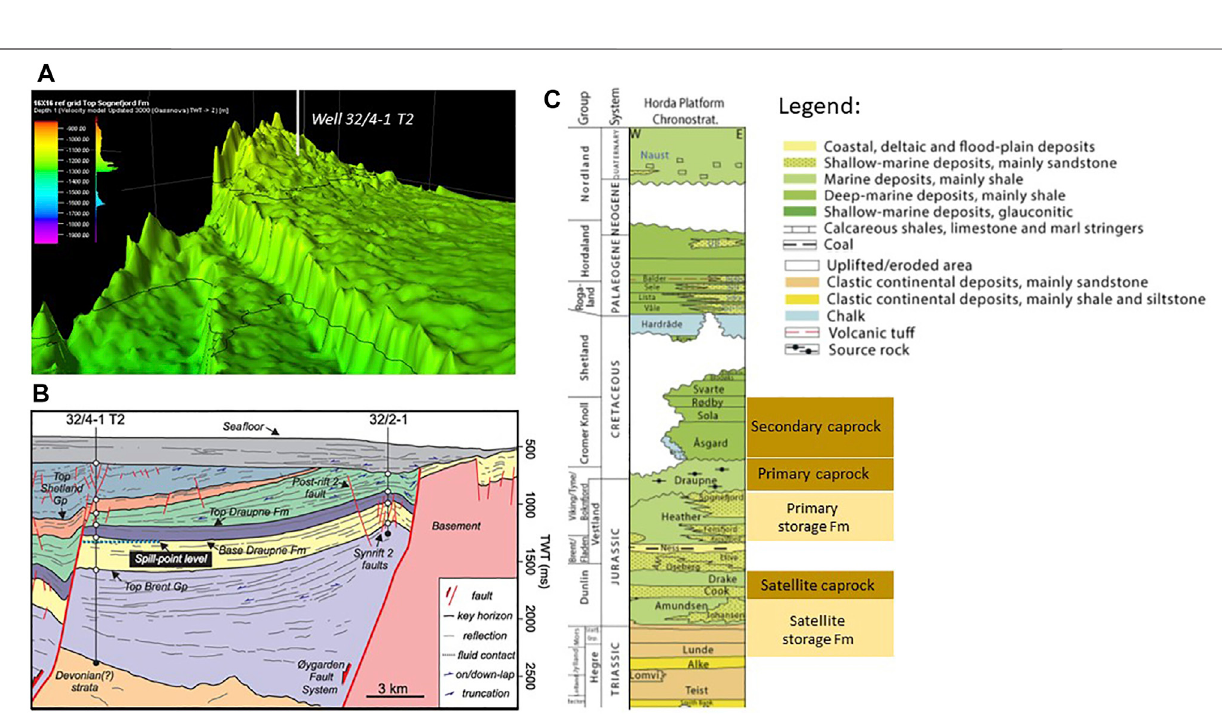
Frontiers in Energy Research |